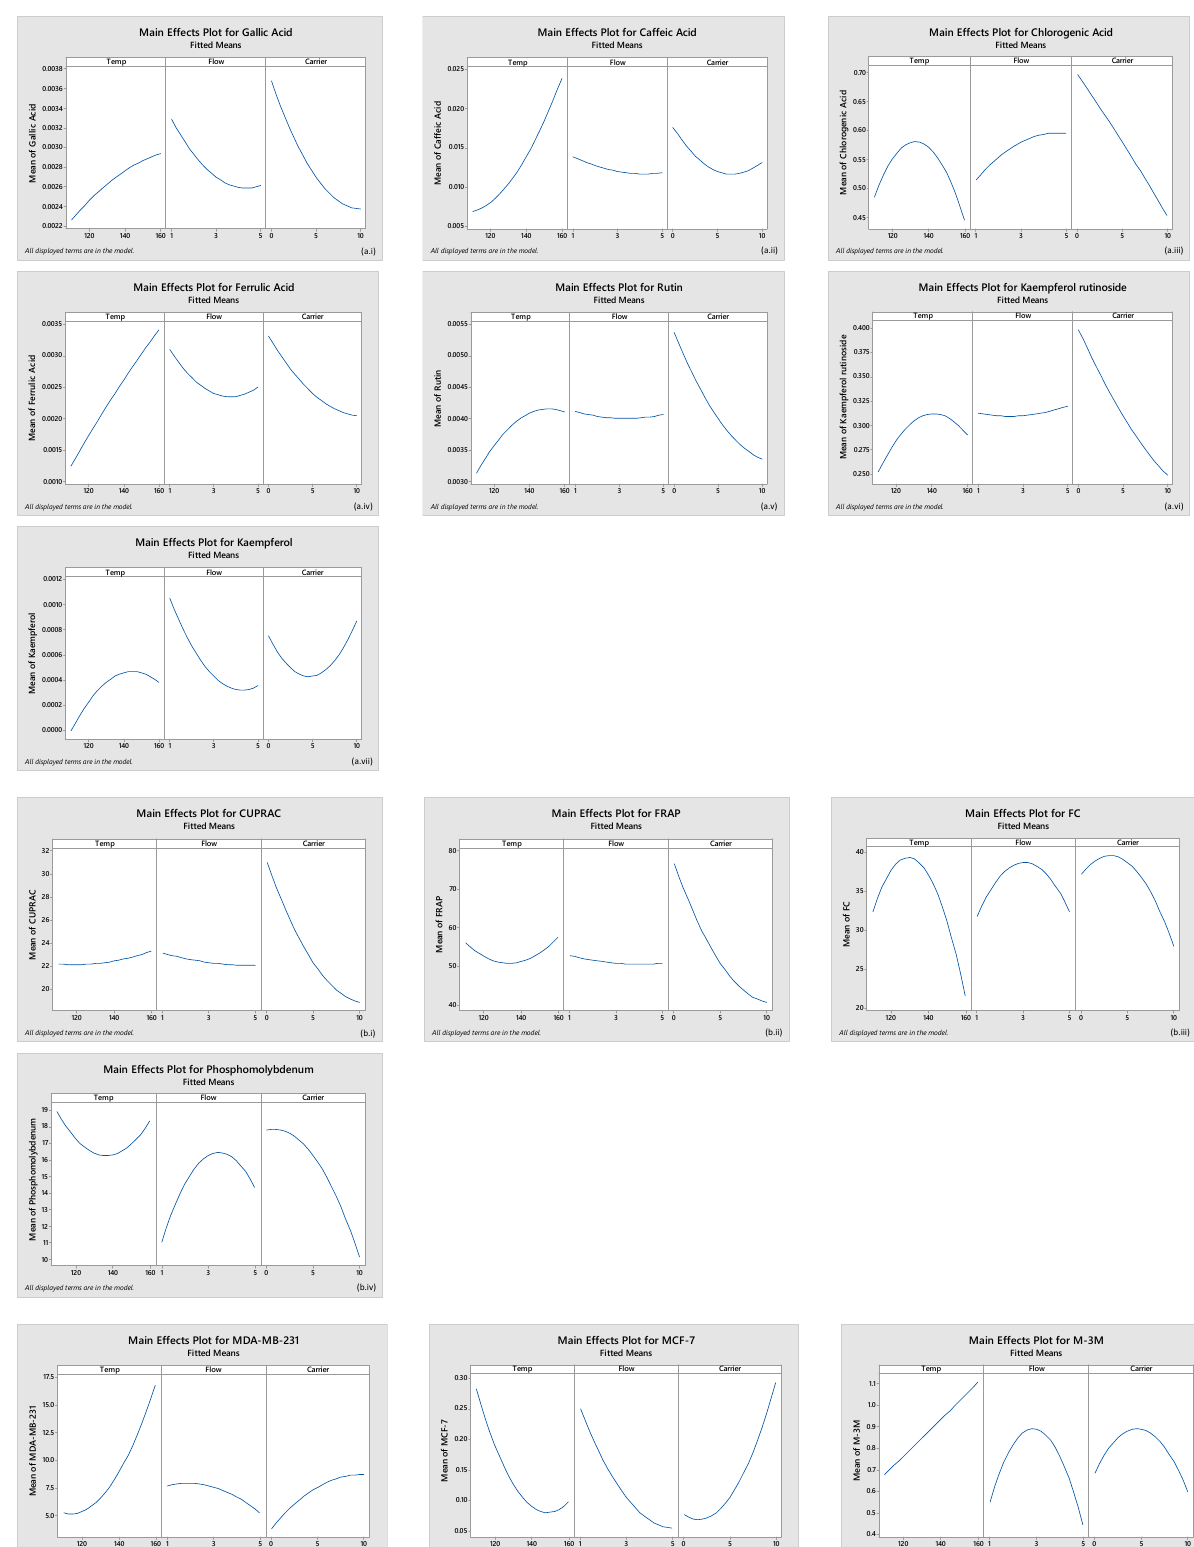
Figure A2. Main effect plots for total phenolic content, antioxidant activity, and anticancer activity.